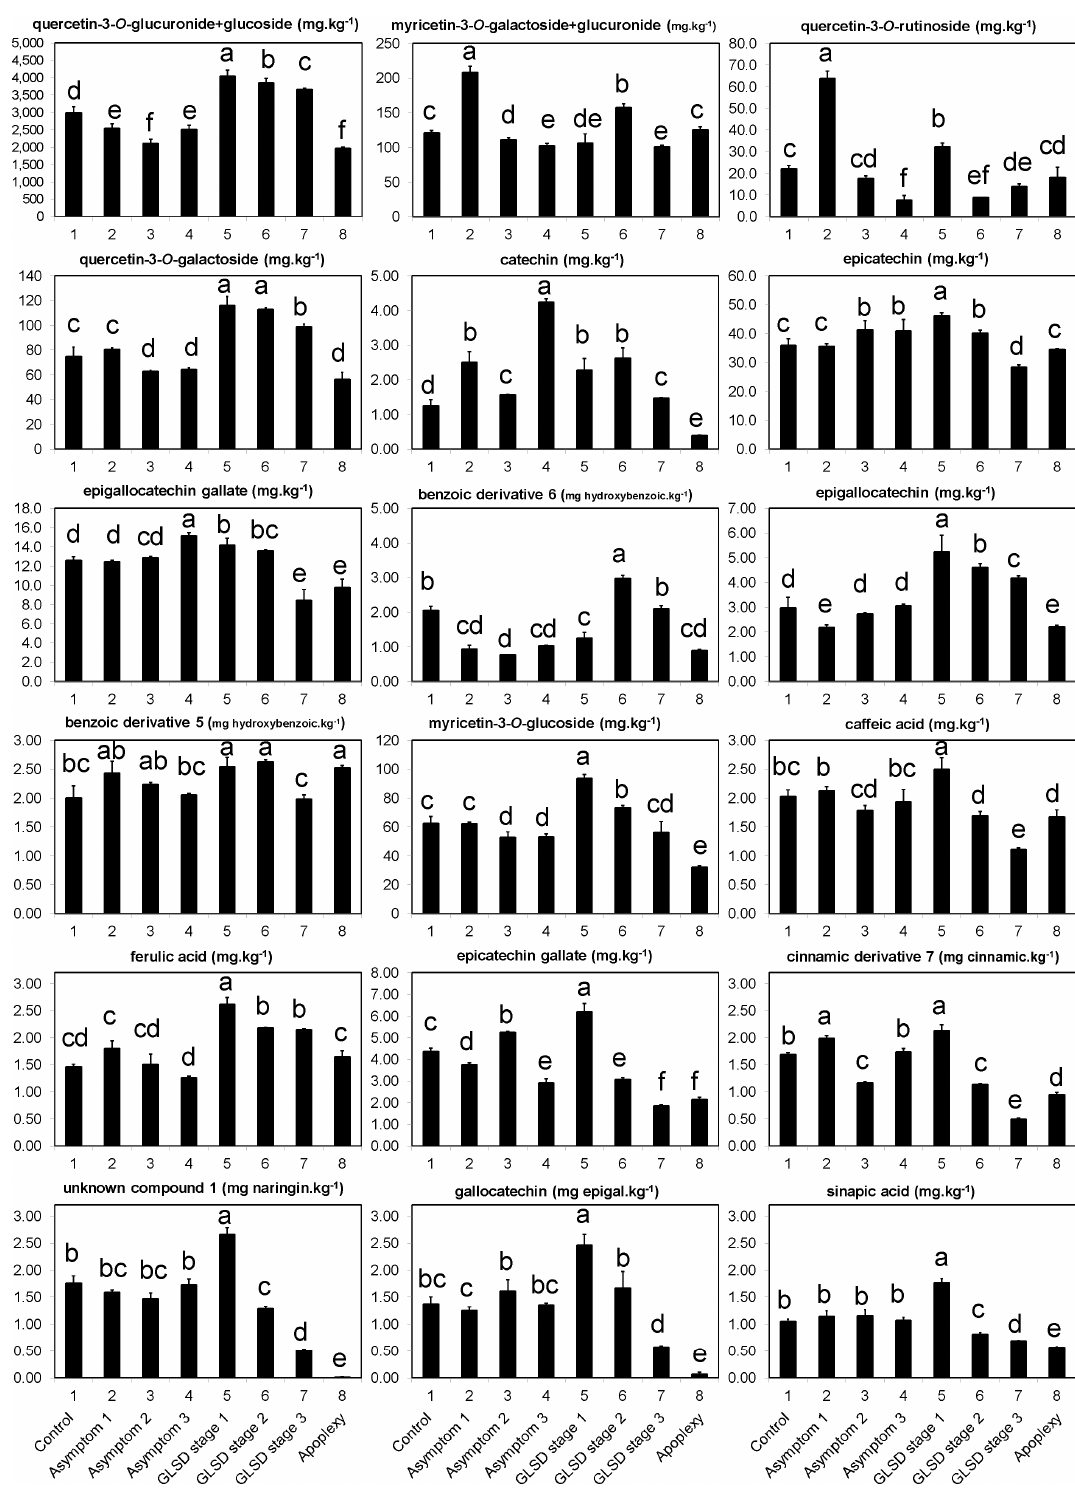
Figure 2. Phenolic compounds in asymptomatic and symptomatic leaves of vines affected by brown wood streaking, grapevine leaf stripe and apoplexy; their levels (dry weight basis) progressively decreased with increasing severity of symptoms. The legend is as in Figure 6. Error bars = standard deviations ( n = 4); different letters above the columns denote statistical differences (Tukey’s test; P ≤ 0.05); hydroxybenzoic = hydroxybenzoic acid; cinnamic = cinnamic acid; and epigal = epigallocatechin.